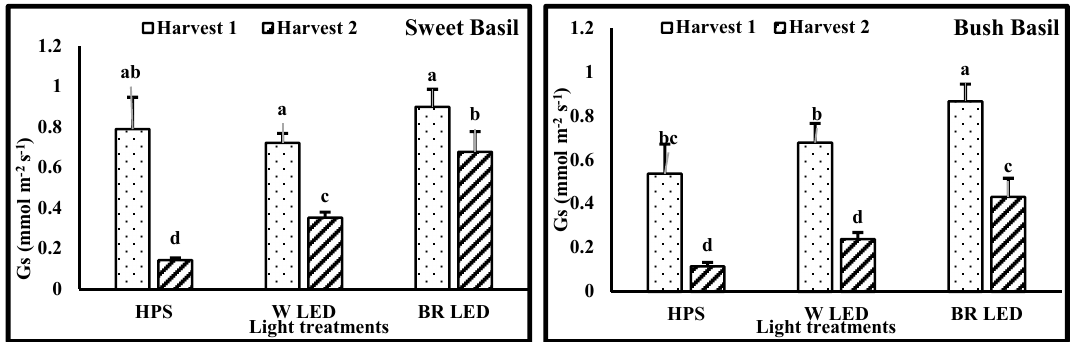
Figure 3. The effect of light treatments and harvest stage on the stomatal conductance Gs in sweet basil (least significant difference test (LSD) = 0.144 for the light treatment, LSD = 0.118 for the harvest stage and LSD = 0.204 for the interaction between light treatments and harvest stage) and bush basil (LSD = 0.13 for the light treatments, LSD = 0.11 for the harvest stage). Different letters denote significant differences between treatments. ( p < 0.05).